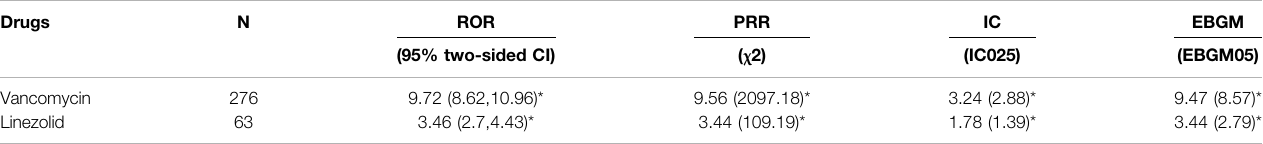
TABLE 2 | Signal detection for vancomycin-associated SJS and linezolid-associated SJS.